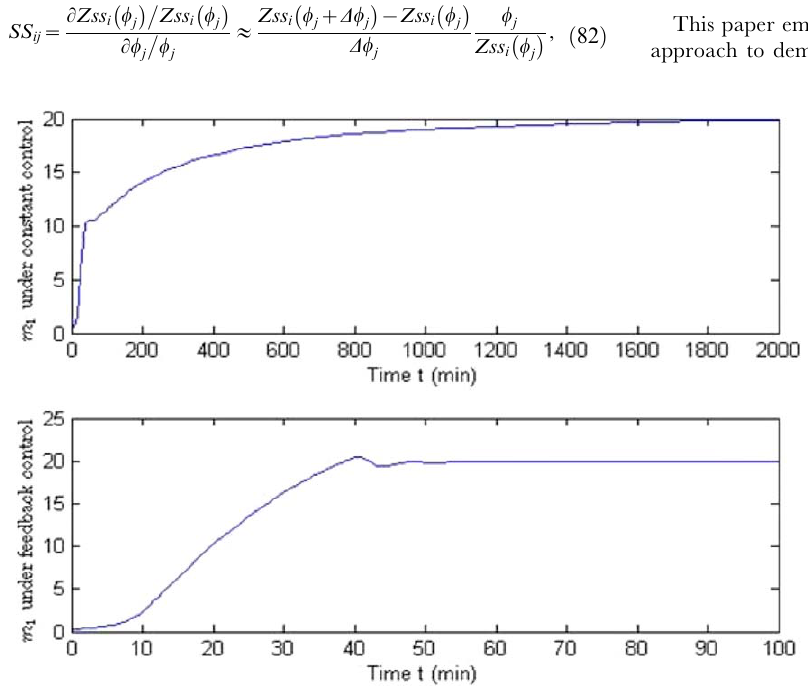
Figure 6. Comparison between constant and feedback control for the Reduced Order Model. It takes more than 1500 min for GAL 1 mRNA, m 1 to reach the desired level of 20 (molec./cell) using the constant control (top); however, only 40 min are required for the feedback control (bottom). According to the simulation, feedback control is much more effective at bringing the yeast system into a steady-state level of mRNA expression.